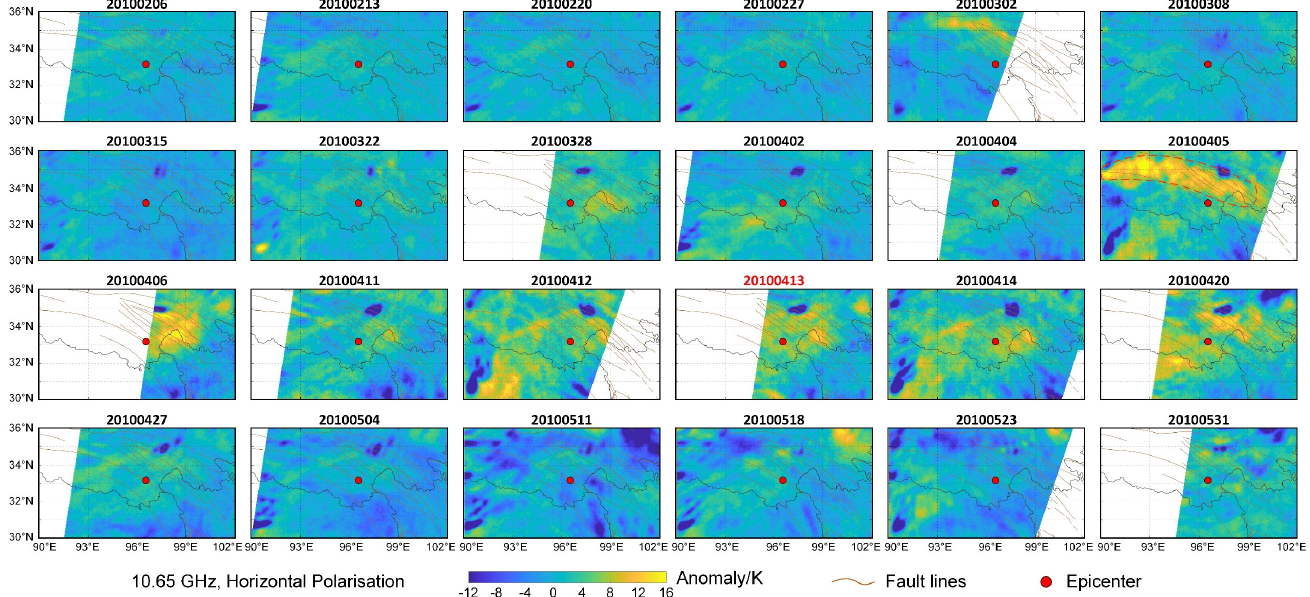
Figure 7. Spatio-temporal evolution of MBT anomalies with 10.65 GHz at H-pol related to the 2010 Yushu EQ.